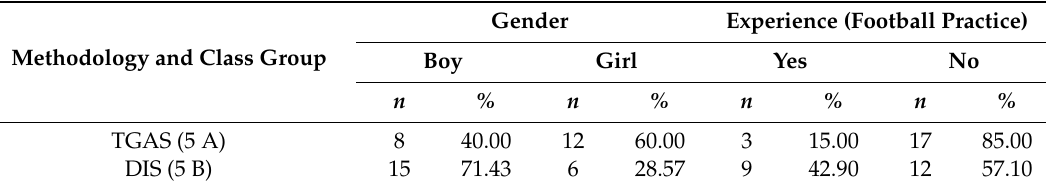
Table 1. Characteristics of the students participating in the study.